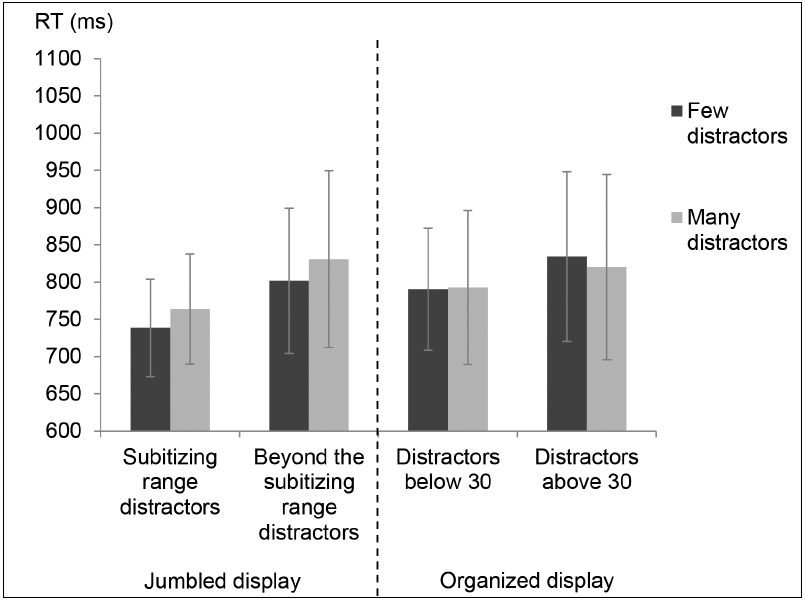
Figure 5. Mean RT and SD for counting subset items in the various conditions in Experiment 2.